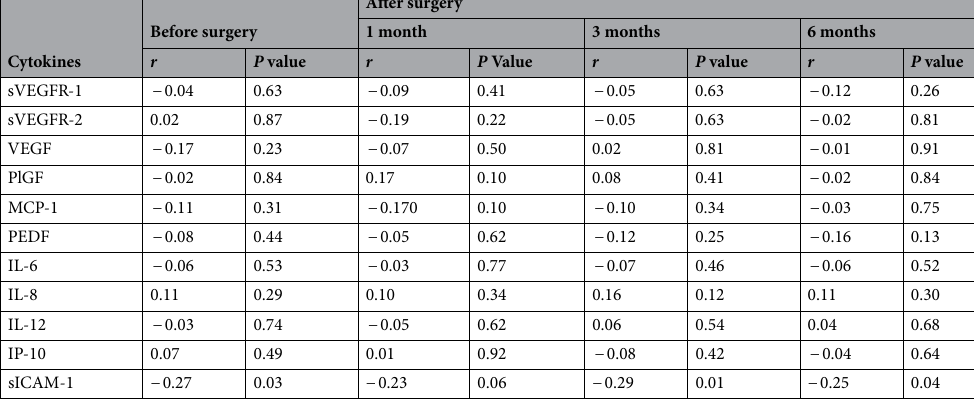
Table 2. Pearson correlation coefficients between cytokine levels in aqueous humor during surgery and r-MBR before surgery and 1, 3, and 6 months after surgery. r-MBR relative mean blur rate on the optic nerve head vessel (RRD eye/fellow eye), sVEGFR soluble vascular endothelial growth factor receptor, VEGF vascular endothelial growth factor, PlGF placental growth factor, MCP-1 monocyte chemoattractant protein-1, PEDF pigment epithelium-derived factor, IL interleukin, IP-10 interferon-inducible 10-kDa protein, RRD rhegmatogenous retinal detachment.